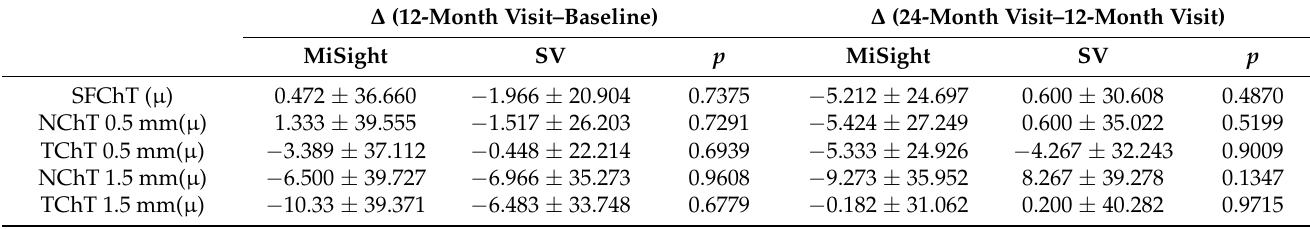
Table 2. Changes (mean ± SD) in subfoveal choroidal thickness (SFChT), nasal choroidal thickness at 1 mm diameter (NChT 0.5 mm), temporal choroidal thickness at 1 mm diameter (TChT 0.5 mm), nasal choroidal thickness at 3 mm diameter (NChT 1.5 mm), and temporal choroidal thickness at 3 mm diameter (TChT 1.5 mm) between the first year of follow-up and baseline, and change in